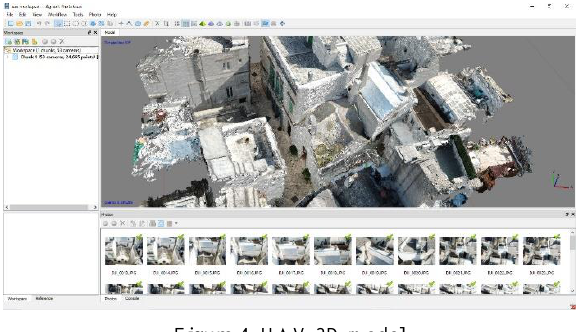
Figure 4. UAV 3D model.